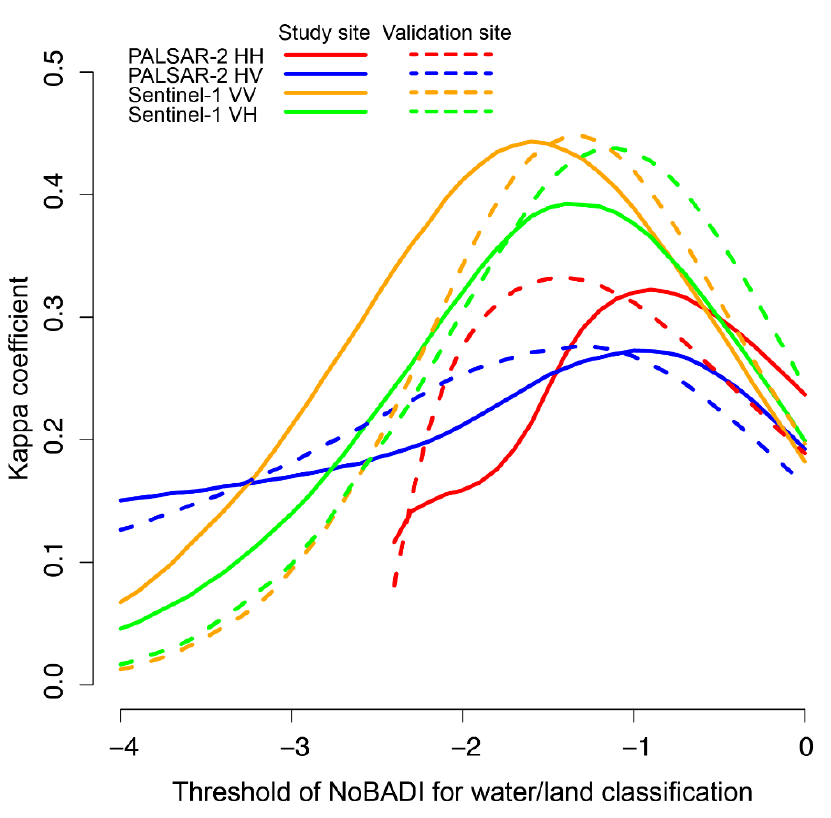
Figure 9. Variations of Kappa coefficients between NoBADI-/optically derived flood-derived water extent for the study site and the validation site. Values correspond to different settings of NoBADI threshold.